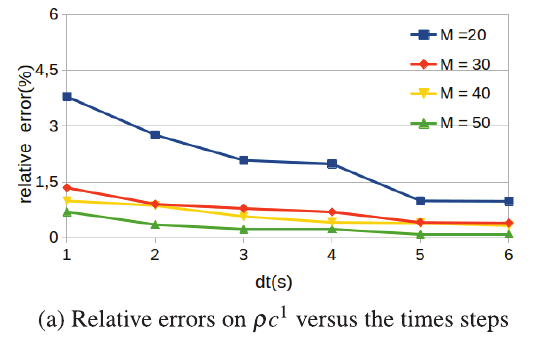
Fig. 5. Relative errors on ρc with noise ( σ = 0 . 4 ◦ C) on the temperature fields for PA material for several times steps ( dt ). reached for a noise of 0.1 ◦ C and 2.2% for a noise of 0.4 ◦